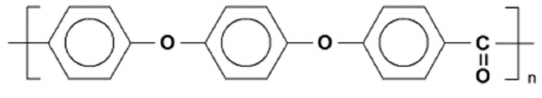
Figure 1. Chemical structure of